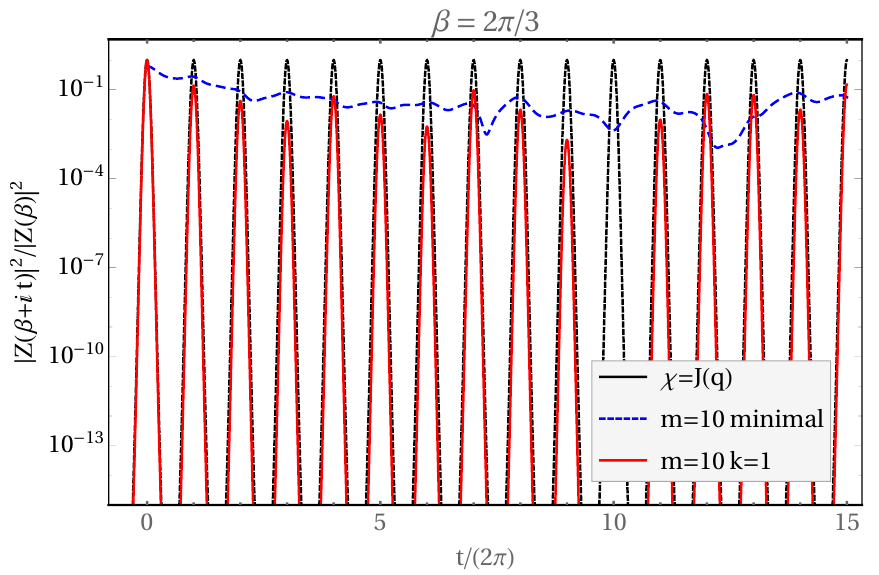
Figure 6 . A plot of the spectral form factor of the m = 10, k = 1 model (following notation in section 3.2) at continuous time t (red solid), compared with the J -function (black short dashed) and the m = 10 minimal model (blue long dashed). The function is clearly dominated by peaks at integer times. The m = 10 ; k = 1 model, if it exists, corresponds to a CFT with central charge c = 24 + 52 = 1372 55 55